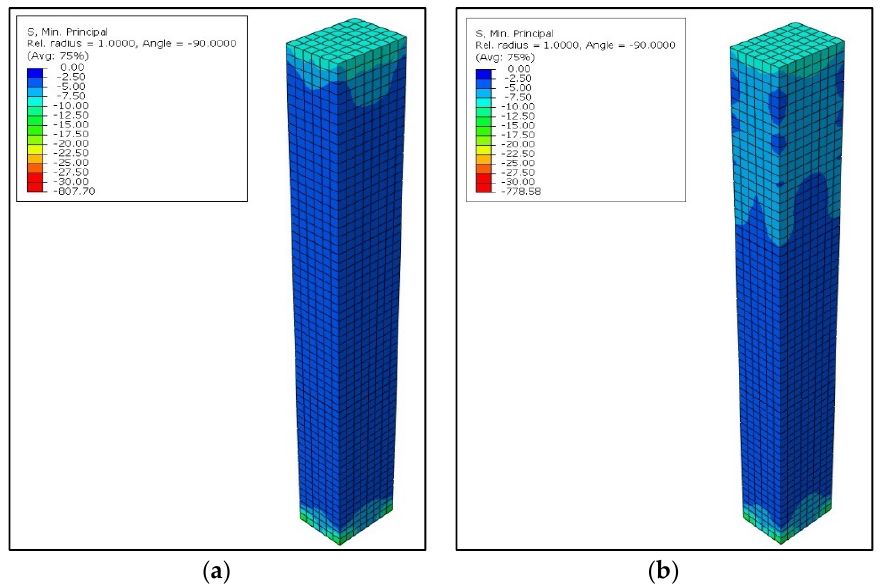
Figure 39. Stress pattern formed along the height of the column (a) C4, (b) C1